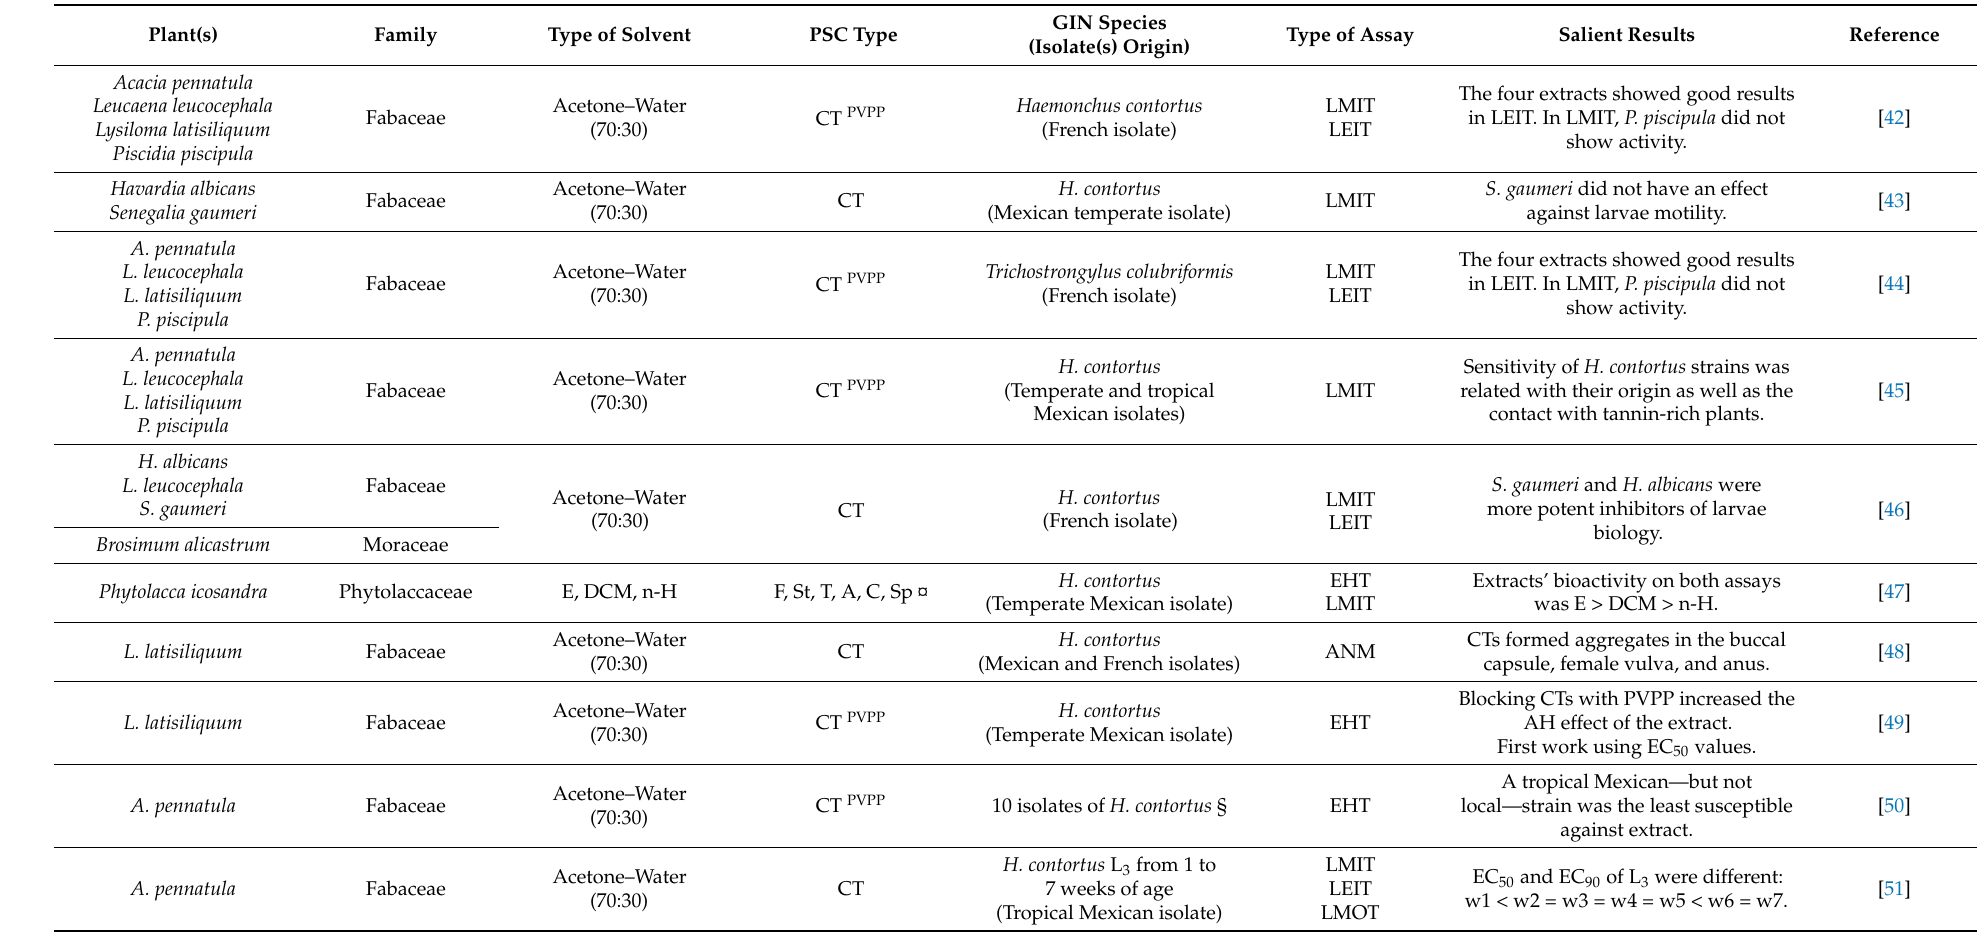
Table 1. Screening the in vitro anthelmintic activity against small ruminant’s gastrointestinal nematodes using different extracts produced from the leaves of plant species present in the low deciduous